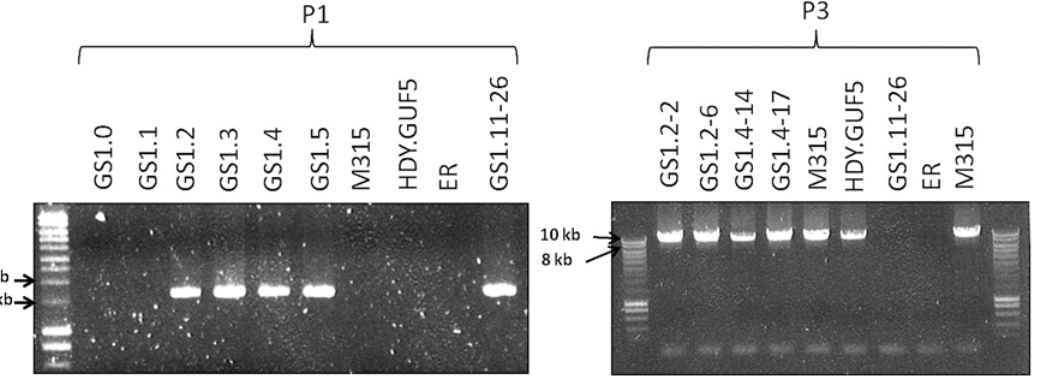
Fig 5. Evaluation of the XylA- locus in cultures and single cell clones obtained from the various stages of the evolutionary adaptation process. Agarose gel electrophoresis of PCR products obtained using primer sets P1 and P3 are shown (see Fig. 3C for the primer sets). DNA was isolated from a sample of the whole culture obtained just after the genome shuffling step (GS1.0) and after each batch of the first 5 cultures of the evolutionary adaptation process (GS1.1 to GS1.5). GS1.2 – 2 and GS1.2 – 6 are single cell isolates from the culture GS1.2, while GS1.4 – 14 and GS1.4 – 17 are single cell isolates from the culture GS1.4. The strains M315, HDY.GUF5, ER, (Ethanol Red) and GS1.11 – 26 have been included for